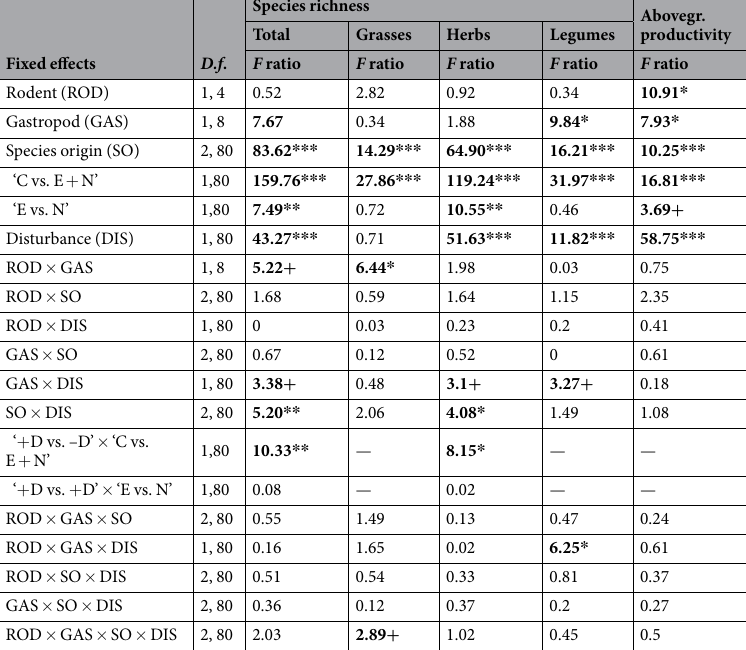
Table 2. Results of linear mixed models testing for the effect of rodent herbivory (rodent control, rodent exclusion), gastropod herbivory (gastropod control, gastropod exclusion), species origin (no seed addition control = C, exotic seed addition = E, native seed addition = N), and disturbance (disturbed = + D, undisturbed = − D) on total, grass, herb and legume species richness and aboveground productivity. Relevant effects are decomposed into orthogonal contrasts to investigate more detailed a-priori hypotheses. Repeated measurements of the same sub-subplots are considered as random effects in all models. D.f . gives the numerator and denominator degrees of freedom. ‘Significant’ F values are shown in bold: + P < 0.10, * P < 0.05, ** P < 0.01, *** P < 0.001.